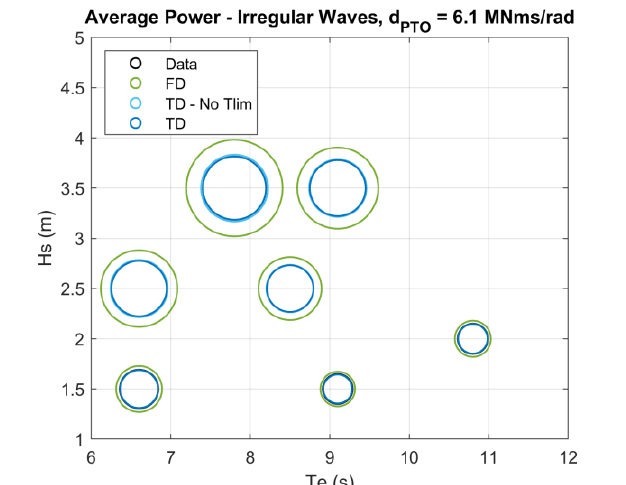
Fig. 11. Power plots Test Set 4. Hs is significant wave height. Te is energy period.